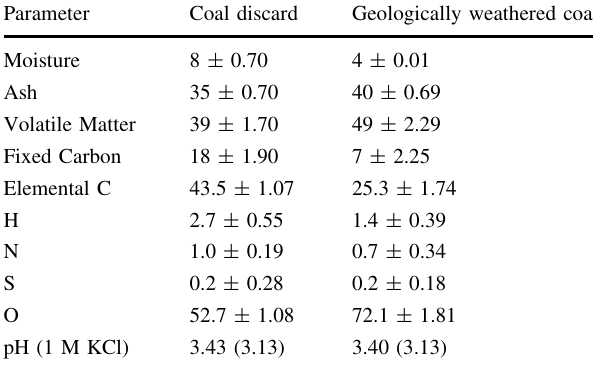
Data are the mean ± SE of six determinations. The mass fraction for each parameter of each substrate was determined, multiplied by 100, and is shown as